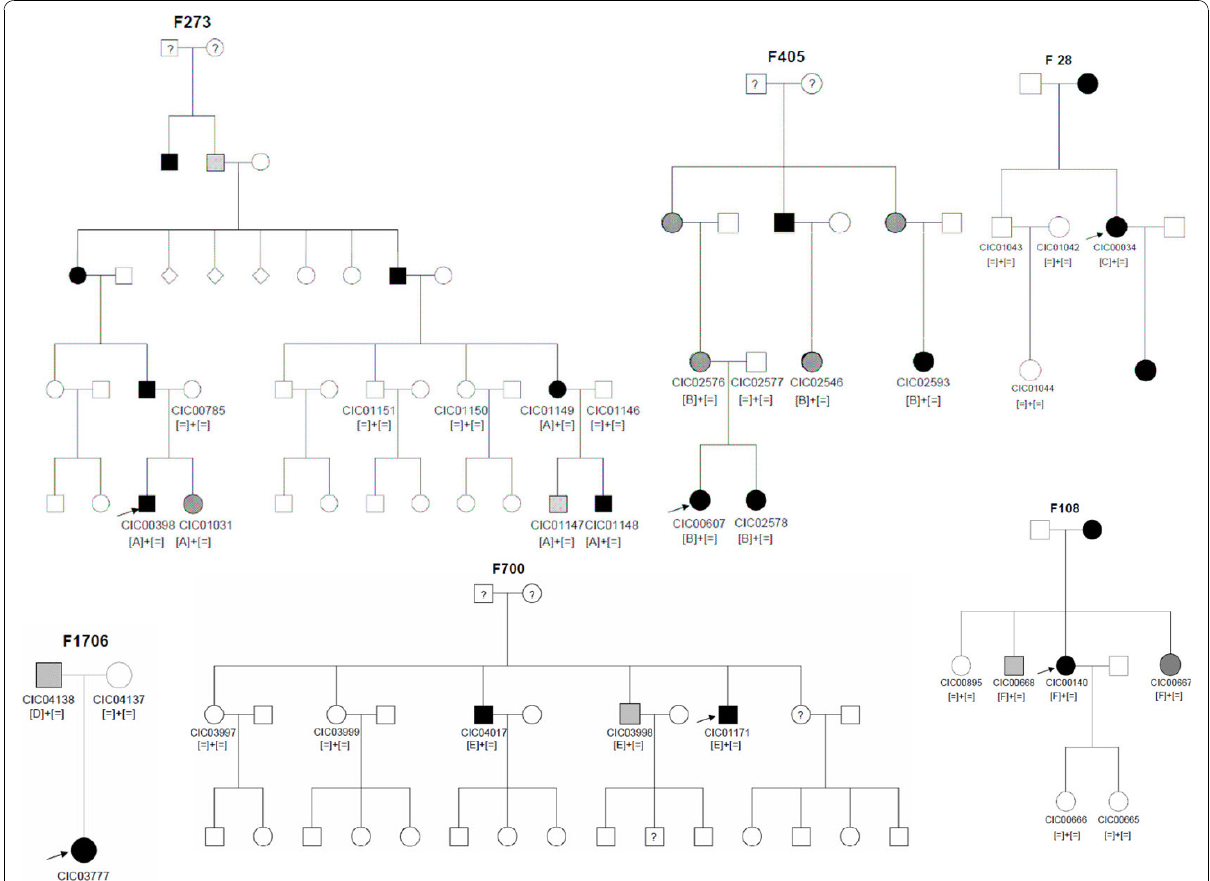
Figure 1 Pedigrees of adRP patients with PRPF31 mutations and co-segregation in available family members . Filled symbols represent affected, unfilled unaffected and dotted asymptomatic individuals. Question marks indicate that it is not clear whether the individual is affected or not. Squares depict males, circles females. Arrows mark the index patients. Equation symbols represent unaffected alleles. The identified mutations were abbreviated as followed: A = c.269_273del, B = c.527+2T>C, C = c.666dup, D = c.709_734dup, E = c.873_897dup and F =